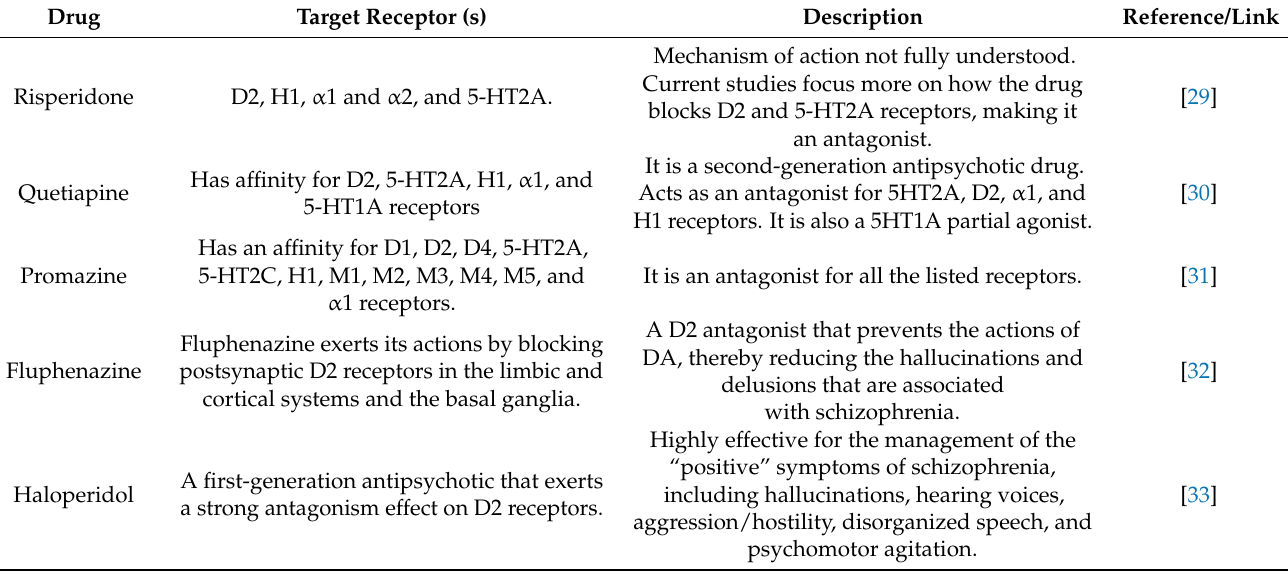
Table 1. Some antipsychotic drugs and the receptors they